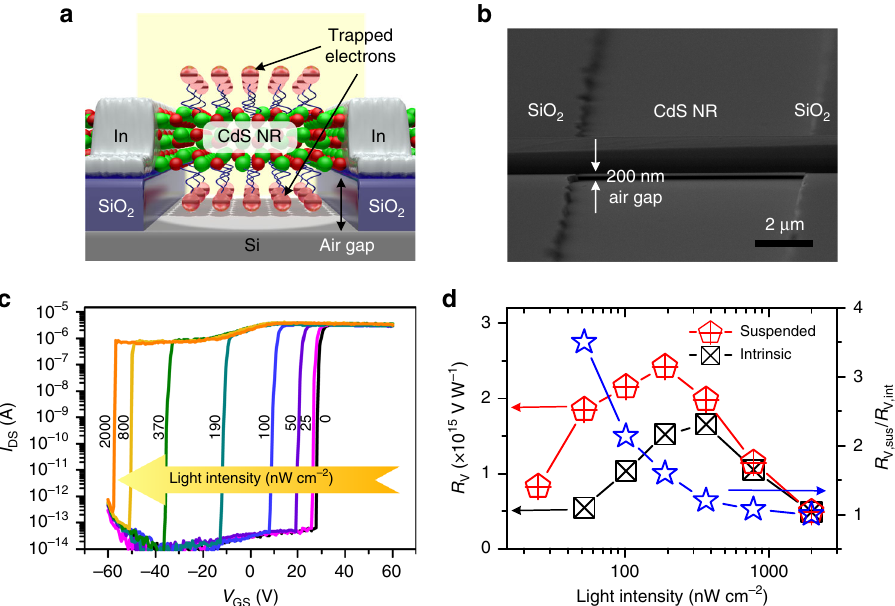
Fig. 4 Suspended CdS NR MPT. a Schematic illustration and b SEM image of the suspended CdS NR MPT fabricated above a channel on the substrate. c Electrical transfer curves of the suspended CdS NR MPT measured in the dark after 10 s of light irradiation under different light intensities of 0 – 2000nW cm − 2 . d Voltage responsivities of normal and suspended CdS NR MPT, as well as their ratio at different light